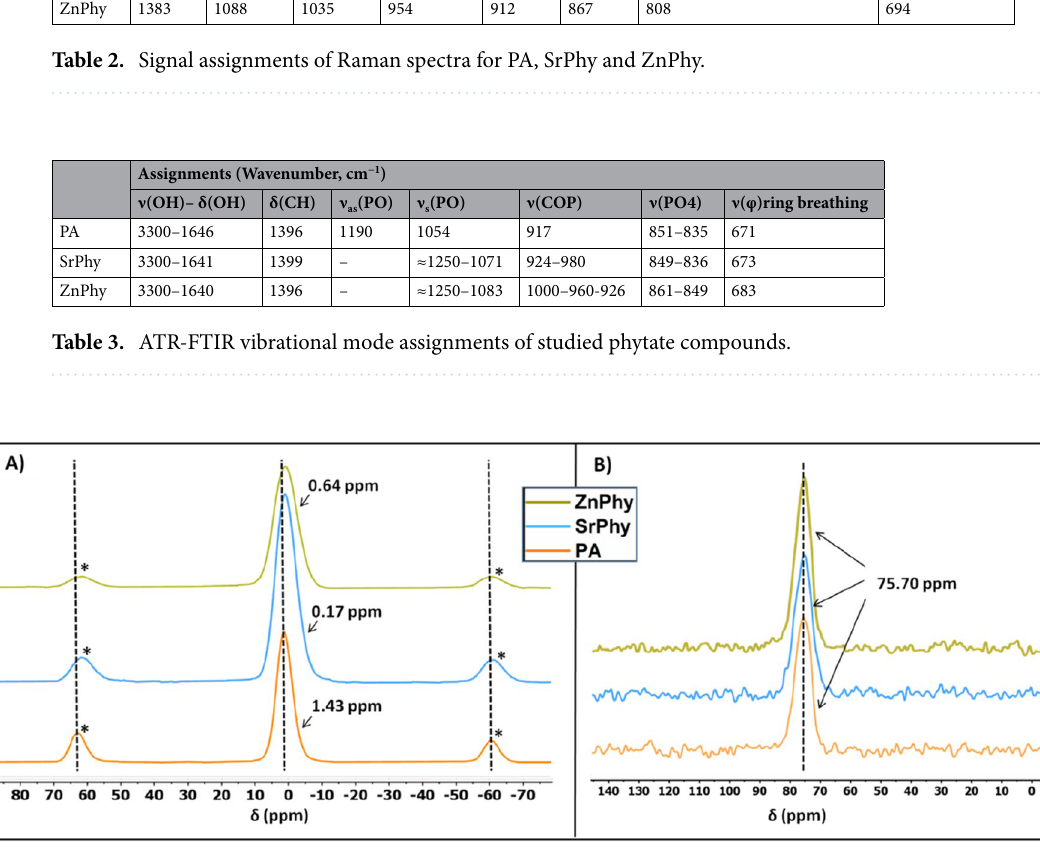
Figure 4. 31 NMR ( A ) and solid 13 NMR ( B ) spectra obtained for PA, SrPhy and ZnPhy. Spinning side bands are marked with